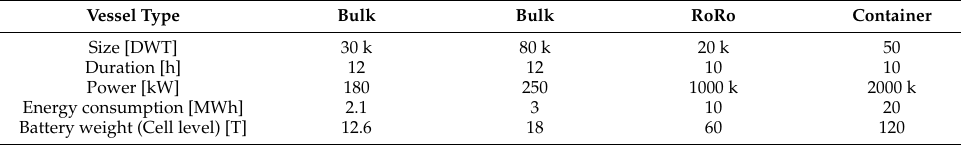
Table 1. Energy consumption on a ship in port and battery storage weight [1,35]. Vessel